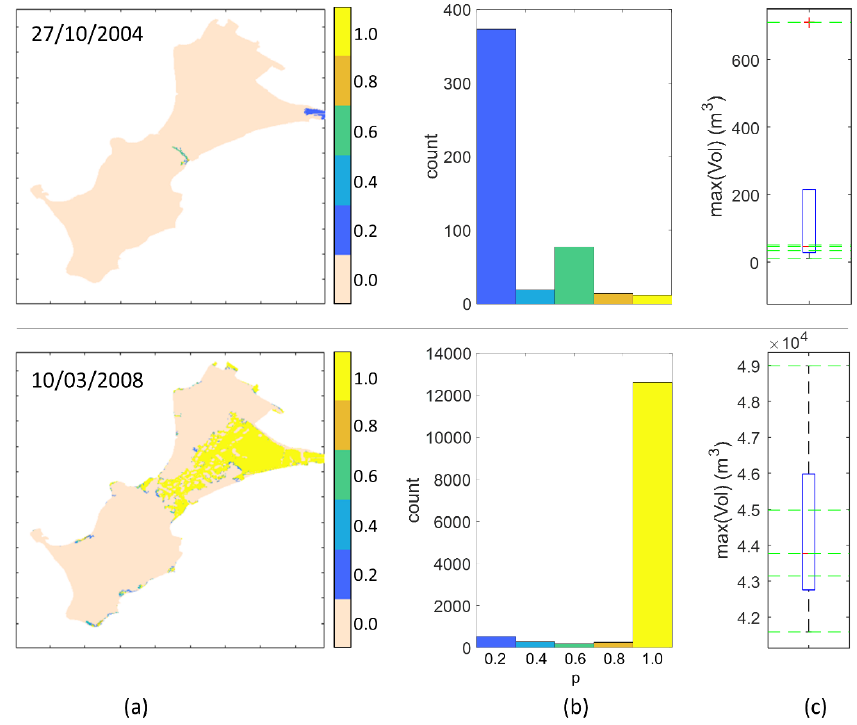
Figure 7. Flood results for the 24 / 10 / 2004 (top panel) and 10 / 03 / 2008 (bottom panel) events: ( a ) maximal inland water height for a subset (for sake of figure readability) of the 5 simulations done for each event, ( b ) standard deviation of the maximal inland water height, computed using the results of the 5 simulations. For each of the two events, the circles highlight some of the areas of differences between the results.